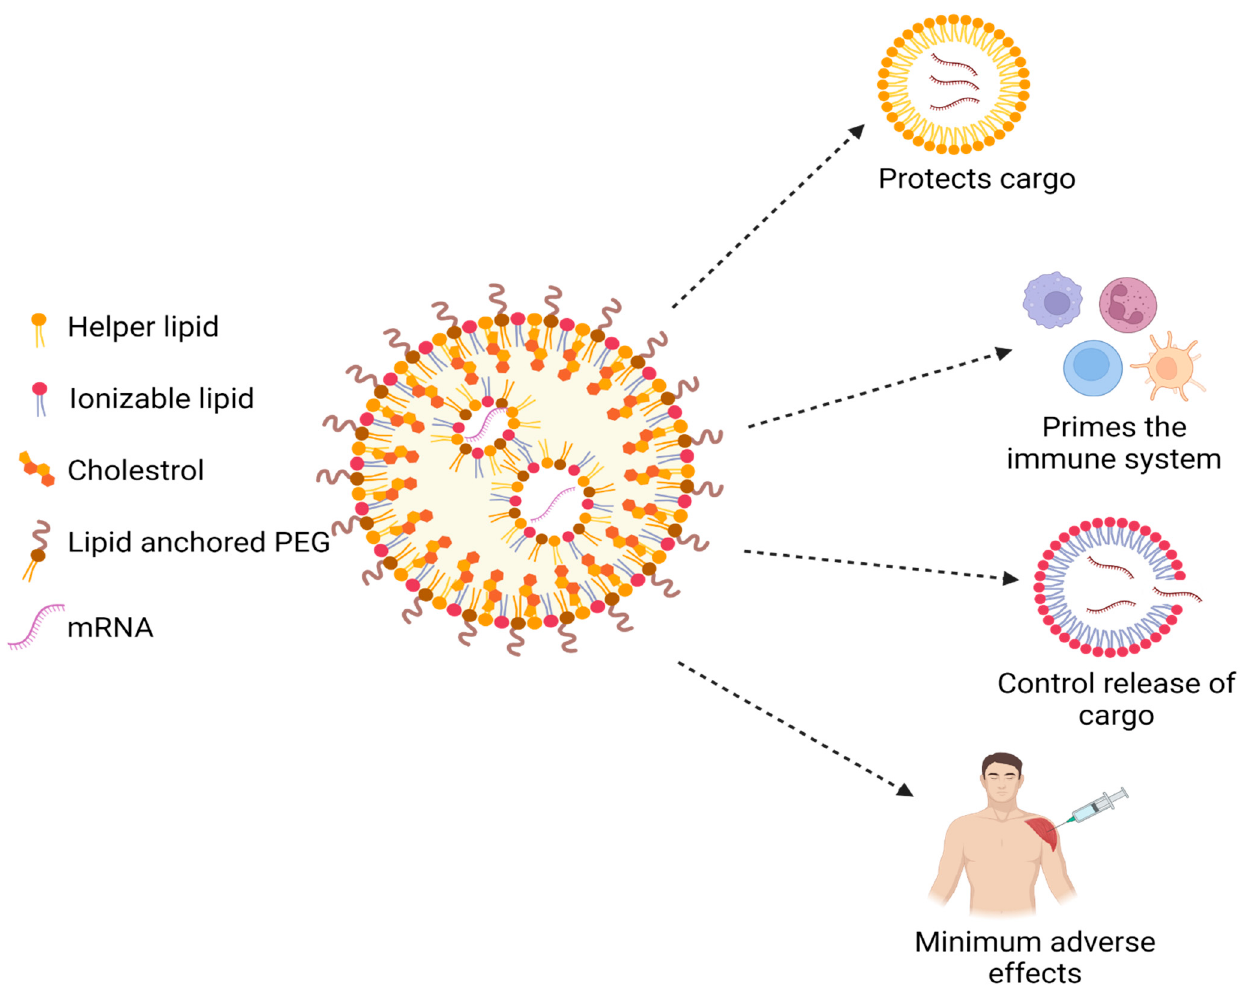
Figure 8. Structure of Lipid Nanoparticles used for efficient mRNA delivery. (Created with BioRen- der.com accessed on 1 January 2023). com accessed on 1 January